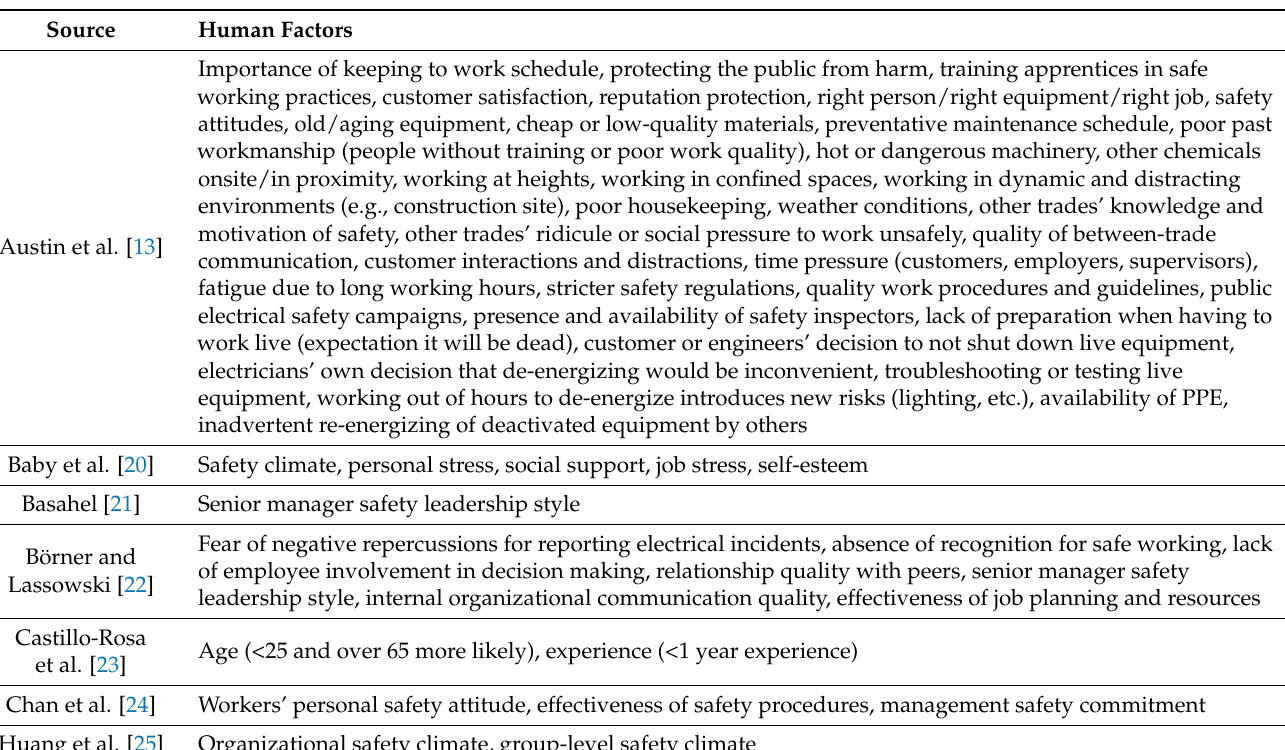
Table 1. Summary of human factors extracted from reviewed